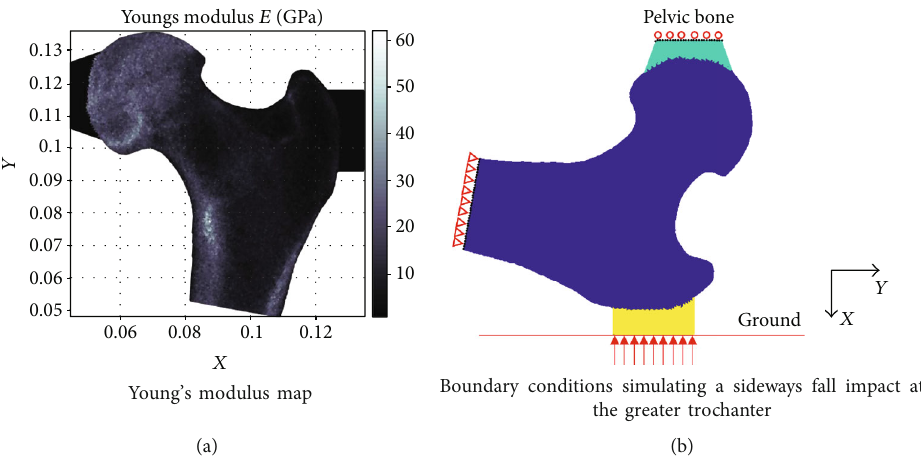
Figure 2: Material properties, loading, and boundary conditions automatically